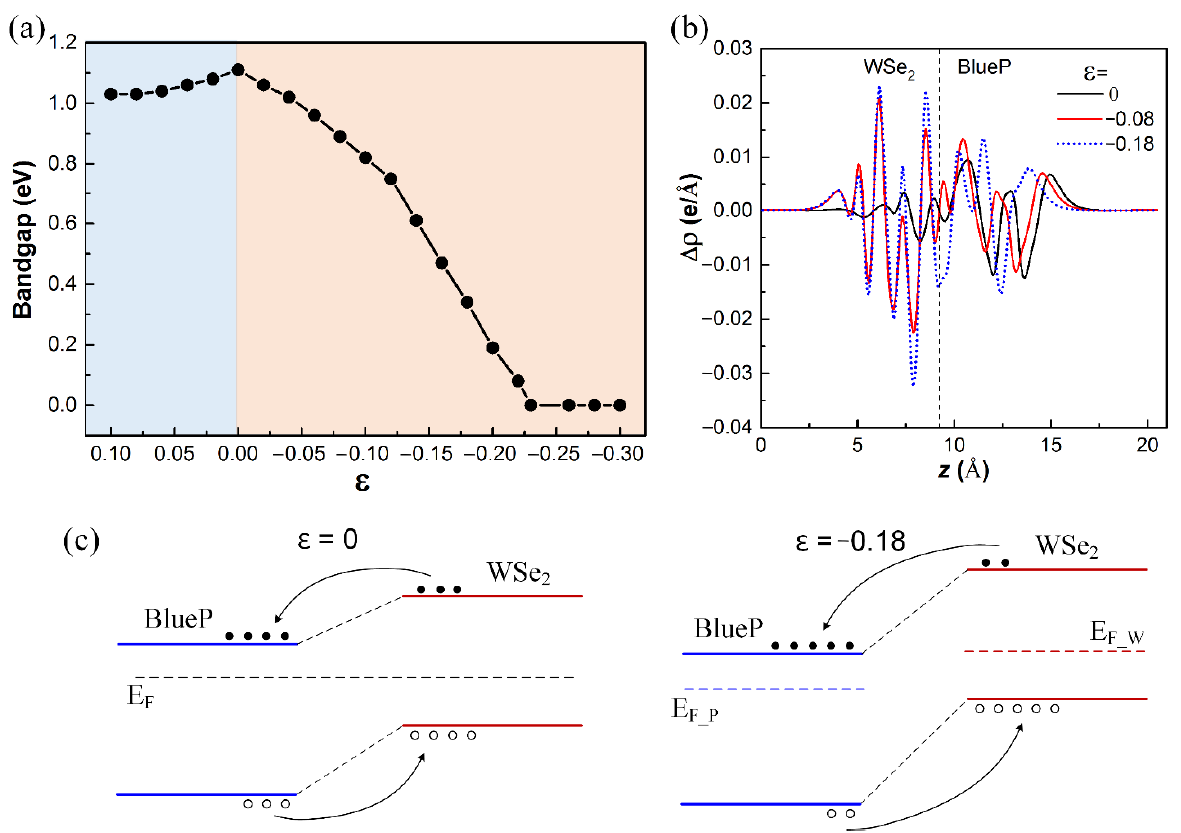
Figure 4. ( a ) Evolution of the bandgap of BlueP/WSe 2 vdW heterostructure as a function of the vertical strain. ( b ) The difference between the integrated charge density of BlueP/WSe 2 vdW heterostructure under different compressive strain and that of isolated monolayers. ( c ) Band alignments of BlueP/WSe 2 vdW heterostructure at the equilibrium state and under a compressive strain of 0.18, respectively.